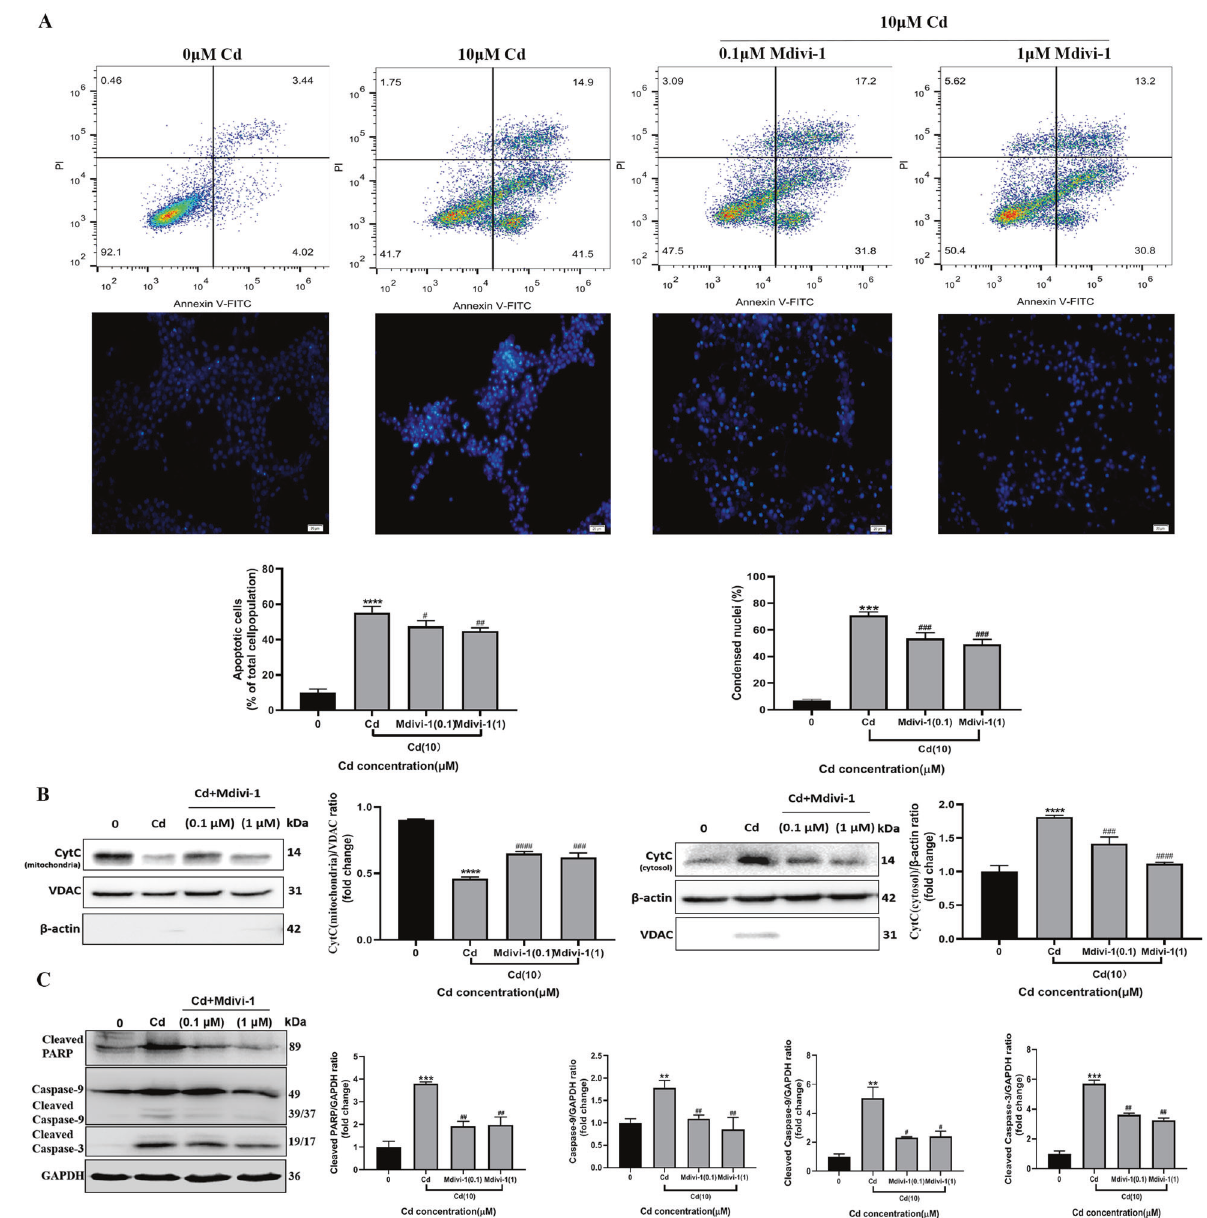
and β -actin were used as internal references for mitochondrial and cytosolic fractions, respectively. C Mdivi-1 inhibited cadmium-induced expression of cleaved PARP, Caspase-9, cleaved Caspase-9 and cleaved Caspase-3. Data represent the mean±SD for three